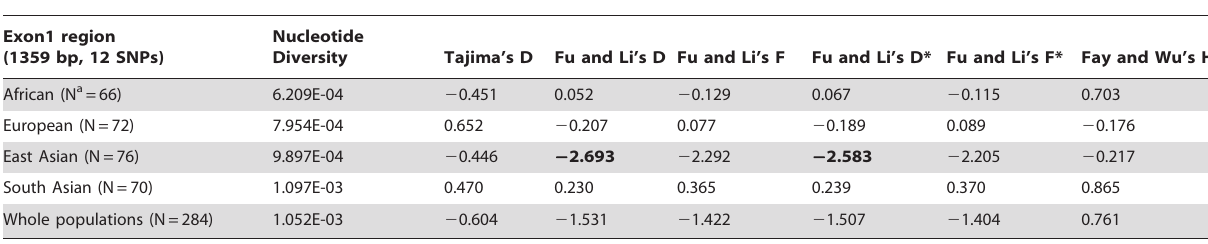
Table 1. Population statistics summary of exon1